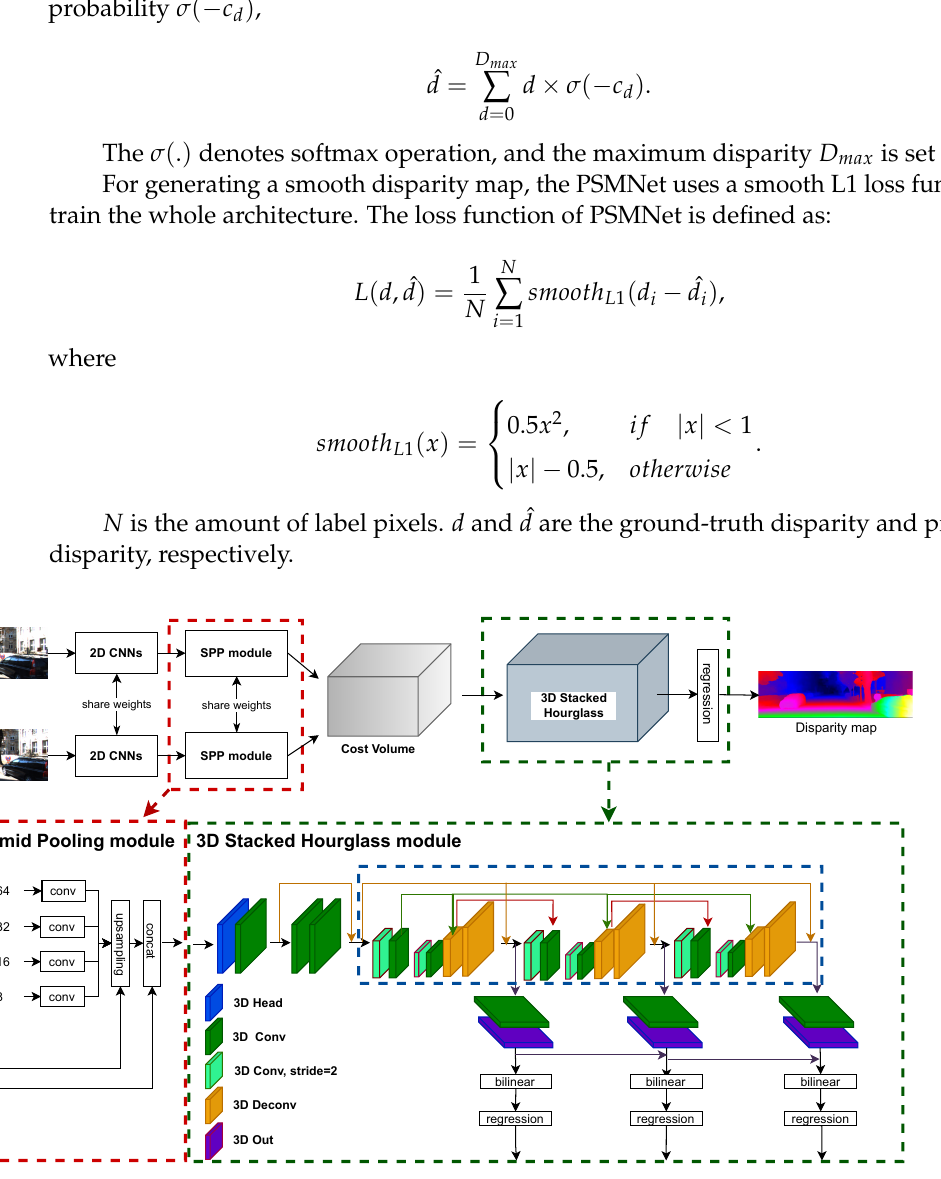
Figure 1. Architecture of PSMNet: We specified all 3D CNN kernels with different colors representing different interactions on the size and channel of cost